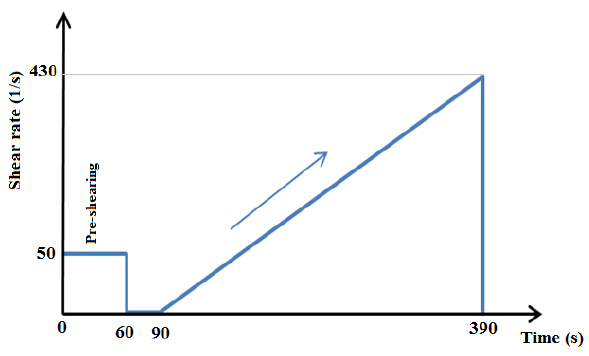
Figure 9: Profile of the imposed rotational speed used in grout rheology